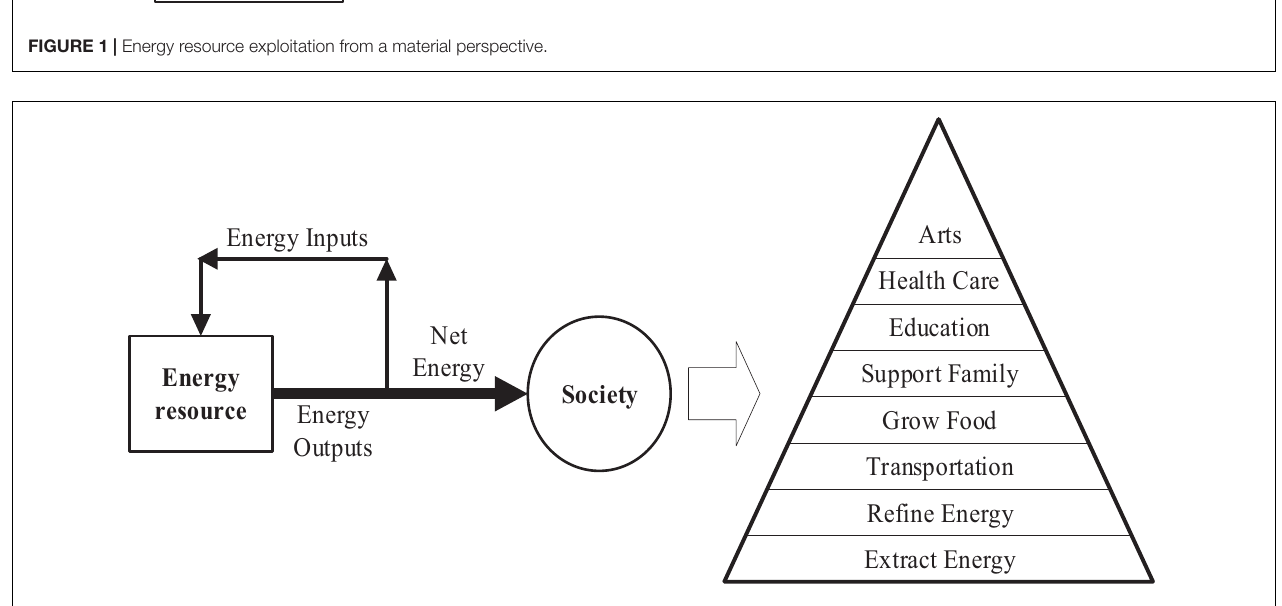
FIGURE 2 | Net energy and pyramid of energetic